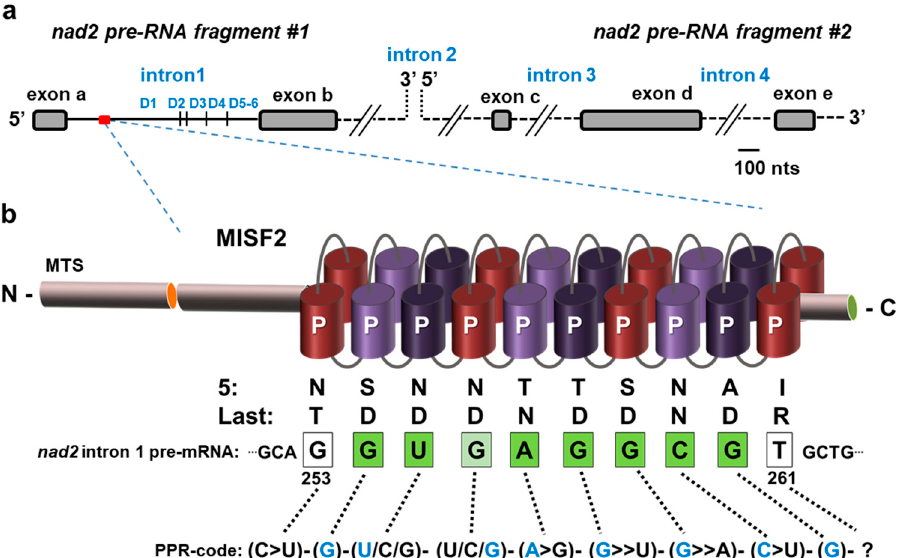
Figure 5. The predicted MISF2 binding site in nad2 intron 1. ( a ) The expression of nad2 in Arabidopsis mitochondria involves the transcription of two precursor RNA transcripts, which are divided by the second intron. The maturation of nad2 requires the splicing of four introns found in cis (introns 1, 3, and 4) or trans (intron 2) configurations. The first pre-mRNA fragment consists of two exons separated by intron 1, while the second fragment harbors three exons separated by introns 3 and 4. The six typical stem-loop domains (D1–D6) are indicated for nad2 intron 1. ( b ) MISF2 is a P-type PPR protein, which harbors a mitochondrial targeting sequence (MTS) and 10 PPR motifs. The fifth and the last amino acids of each PPR repeat (Figure S1) are indicated below each PPR repeats. The best corresponding RNA binding site (i.e., 5 ′ -GUGAGGCG-3 ′ ) is indicated within the first intron of nad2 pre-RNA fragment #1, with bases marked in green for perfect matches to the proposed binding site, in pale green for partial matches, and white for non-matching or unassigned nucleotides.